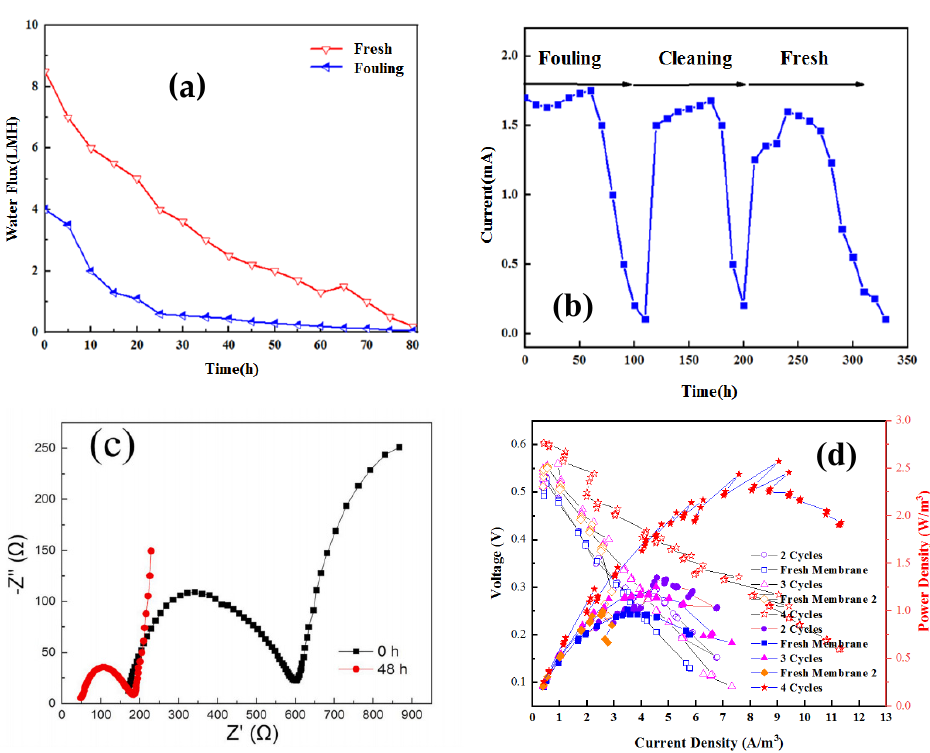
Figure 6. Testing of new membranes and pollutants: water flux change of new membranes and polluted membranes ( a ); current curve of new membrane and polluted membrane ( b ); Nyquist diagram of new and old membranes ( c ); OsMFC polarization curves ( d ) of new membranes and membranes with different operating cycles.